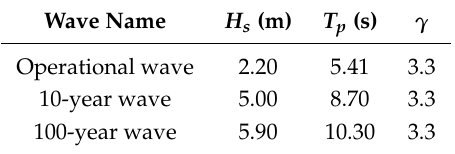
Table 4. Meteocean reference data.